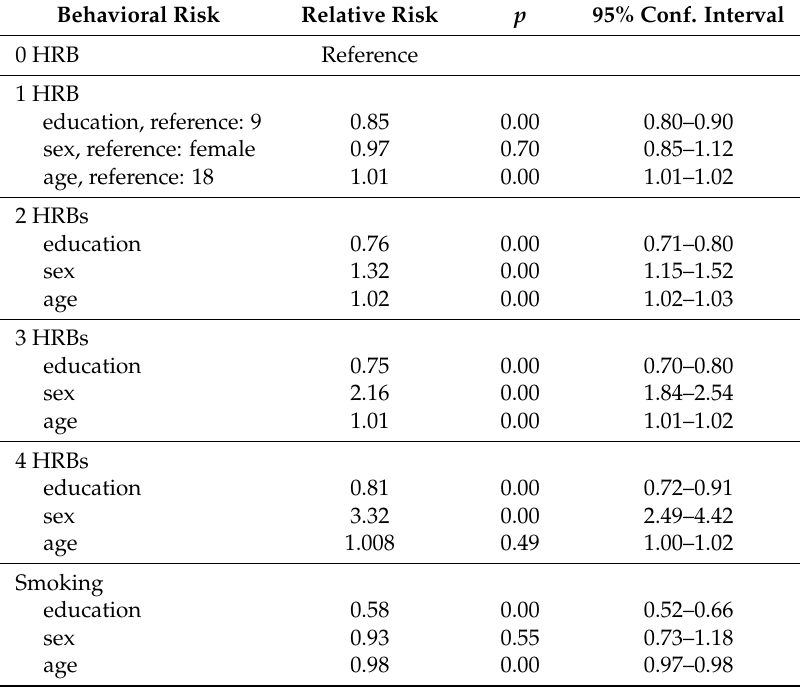
Table 3. Associations between sex, age, level of education, and health risk behavior